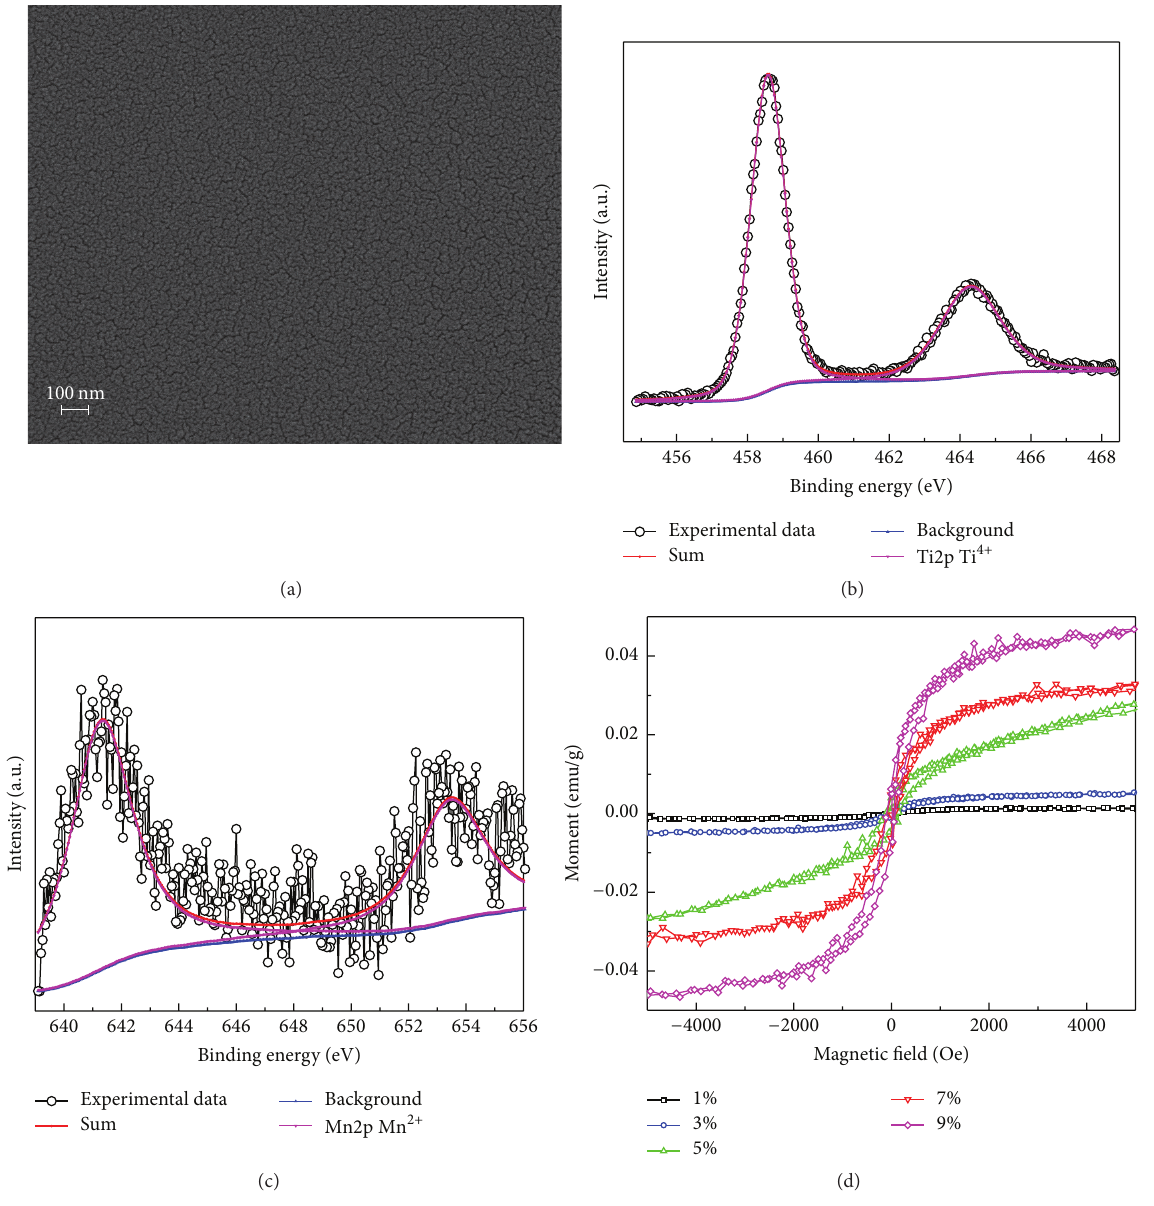
Figure 5: (a) SEM image of Ti 0.97 Mn 0.03 O 2 film; (b) XPS spectra of the core-level signal of Ti-2p and (c) Mn-2p of Ti 0.97 Mn 0.03 O 2 film; (d) magnetic hysteresis curves of the Mn-doped TiO 2 films with 1%, 3%, 5%, 7%, and 9% doping content measured at